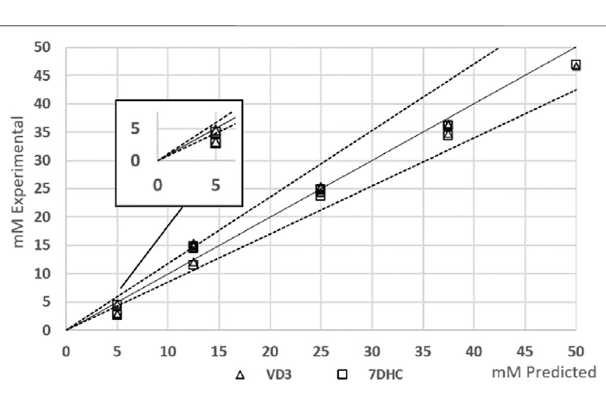
FIGURE 2 | Effect of mass losses using automated high-p,T